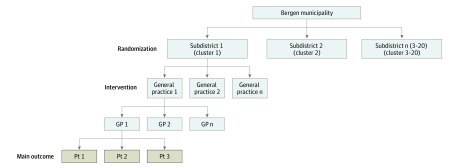
Overview of the Intervention LevelsGP indicates general practitioner; and Pt, patient.